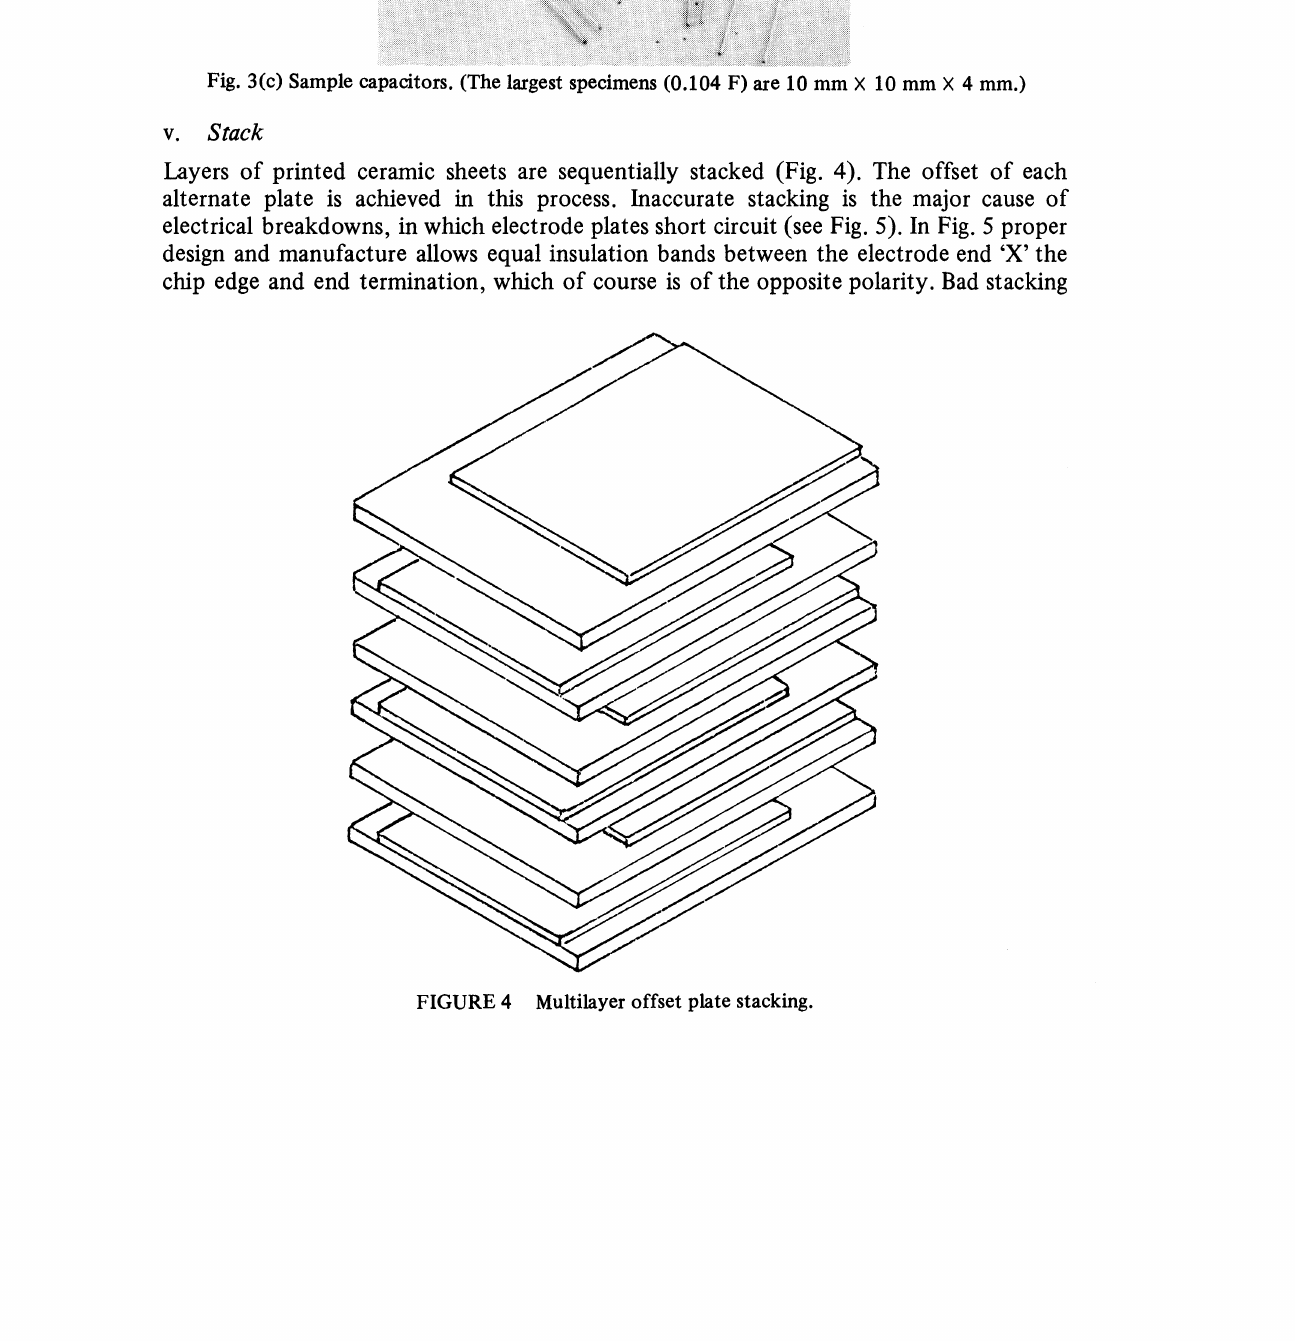
FIGURE 4 Multilayer offset plate